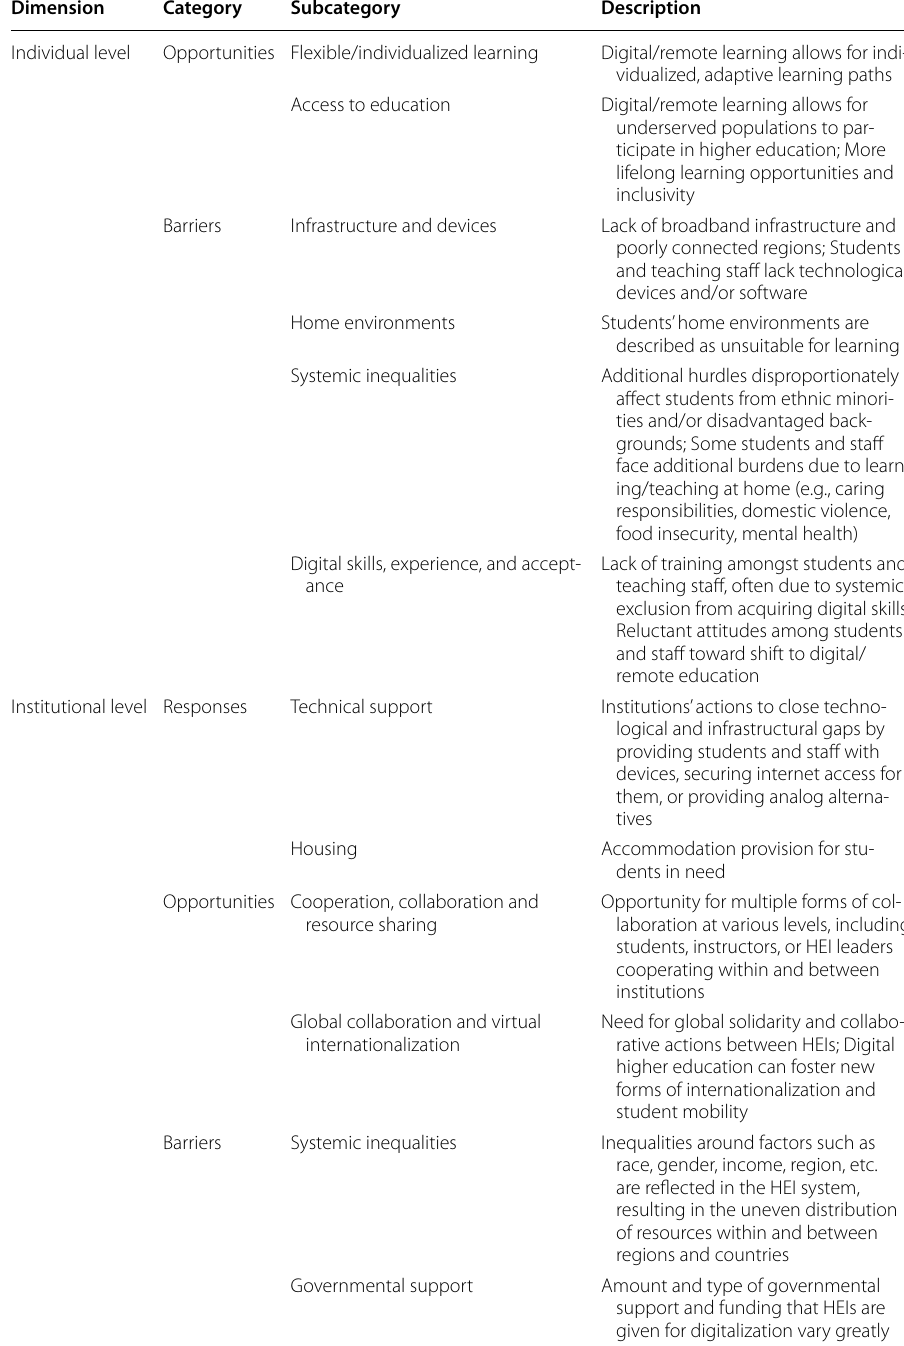
Table 1 Findings